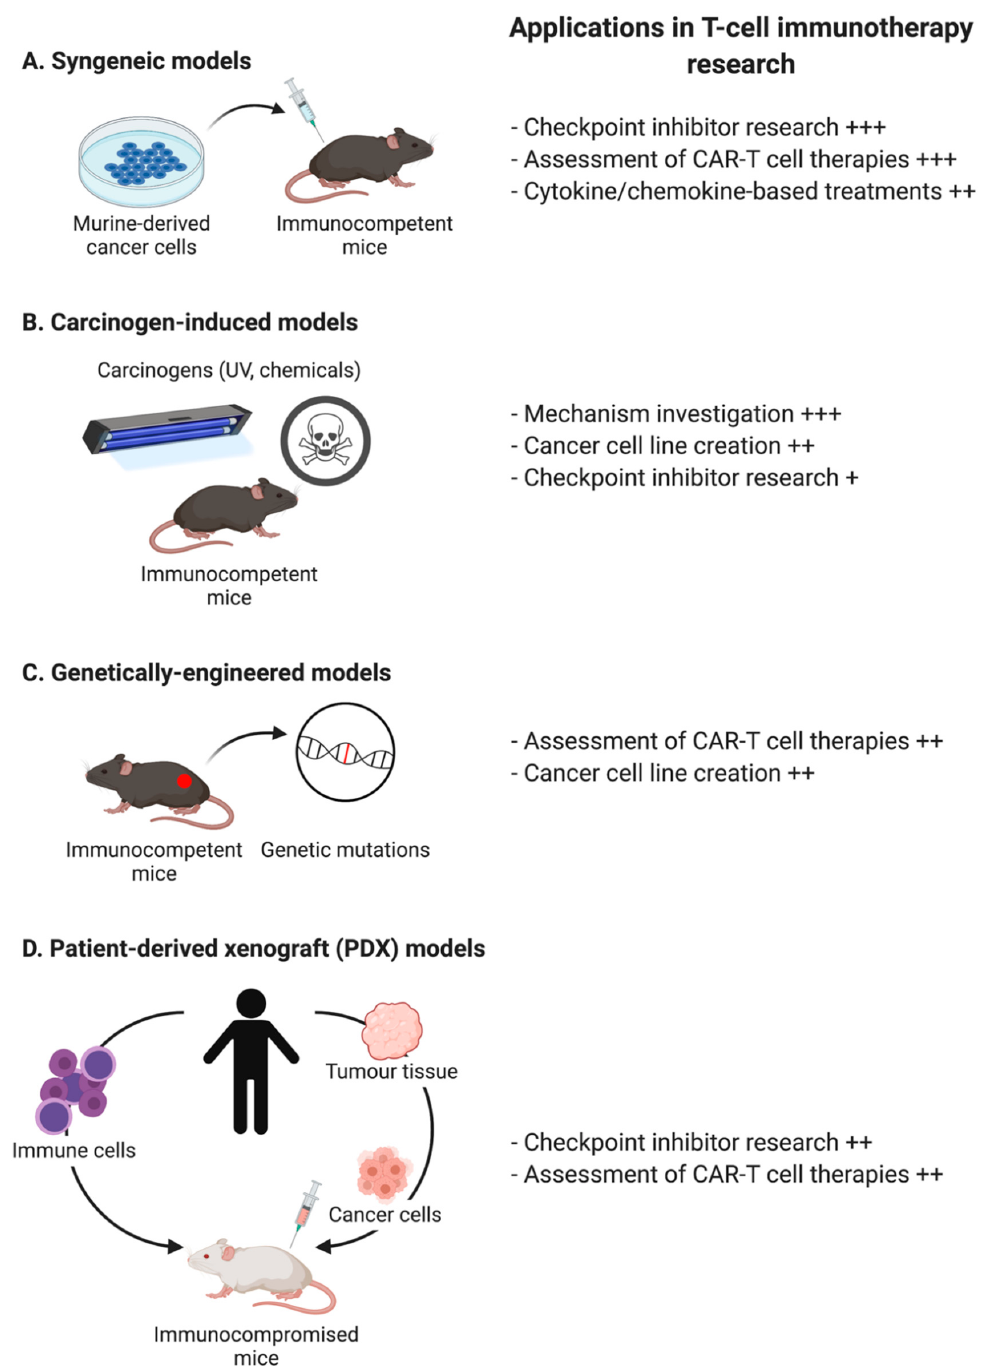
Figure 2. Murine models for evaluation of T cell-directed tumour immunotherapy. ( A ) Syngeneic models utilize murine- derived cancer cell lines grown and expanded in vitro and then injected into immunocompetent mice (commonly either subcutaneously or orthotopically); ( B ) Carcinogen-induced models utilize carcinogens such as ultraviolet light or chemicals to induce mutations resulting in the formation of de novo tumours; ( C ) Genetically engineered models involve transgenic technologies to induce depletion of tumour suppressor genes or expression of oncogenes, which drives autochthonous tumour growth; ( D ) Patient-derived xenograft (PDX) models involve collecting patient tumour material and injecting it into immunocompromised mice. Cancer cells obtained from tumour tissues can be injected alone or in concert with immune reconstitution by autologous immune cells or stem cells. Frequencies are implicated as: +++, frequently; ++, in some cases; +, rarely. Figure inspired by references [103] and [119].